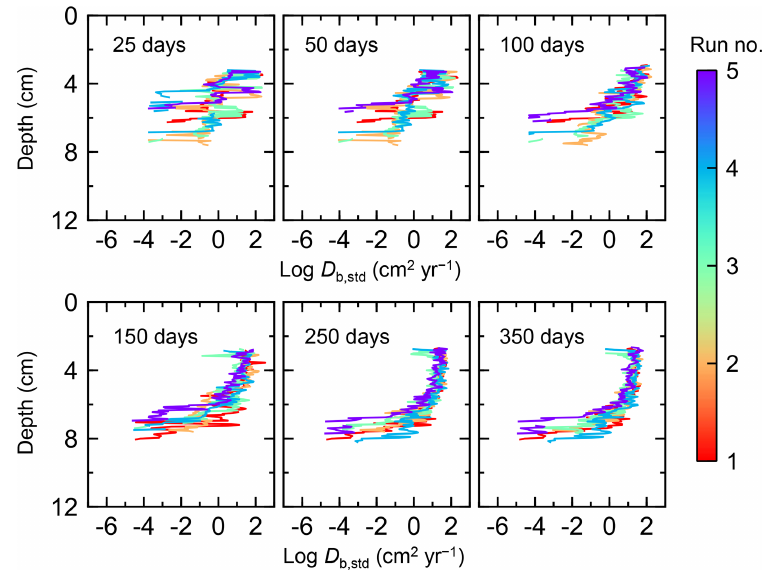
Figure D1. Time evolution of the biodiffusion coefficient ( D b ) for five runs of default simulation (simulation a in Sect. 3.1) in order to illustrate the effect of stochastic animal